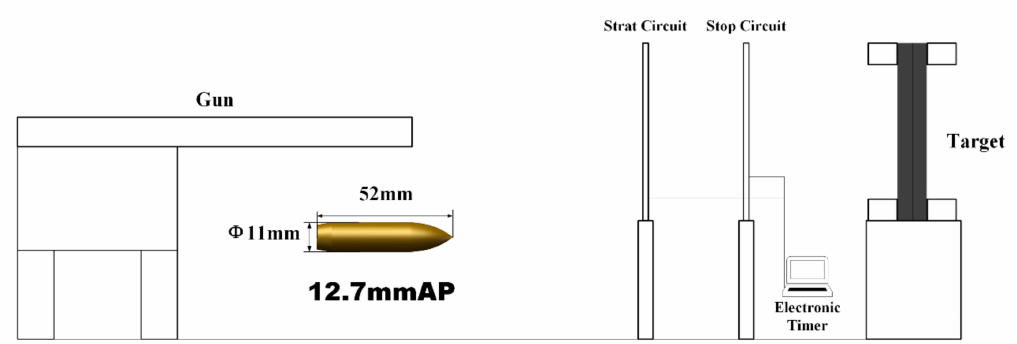
Figure 2. Schematic of the ballistic experiment.